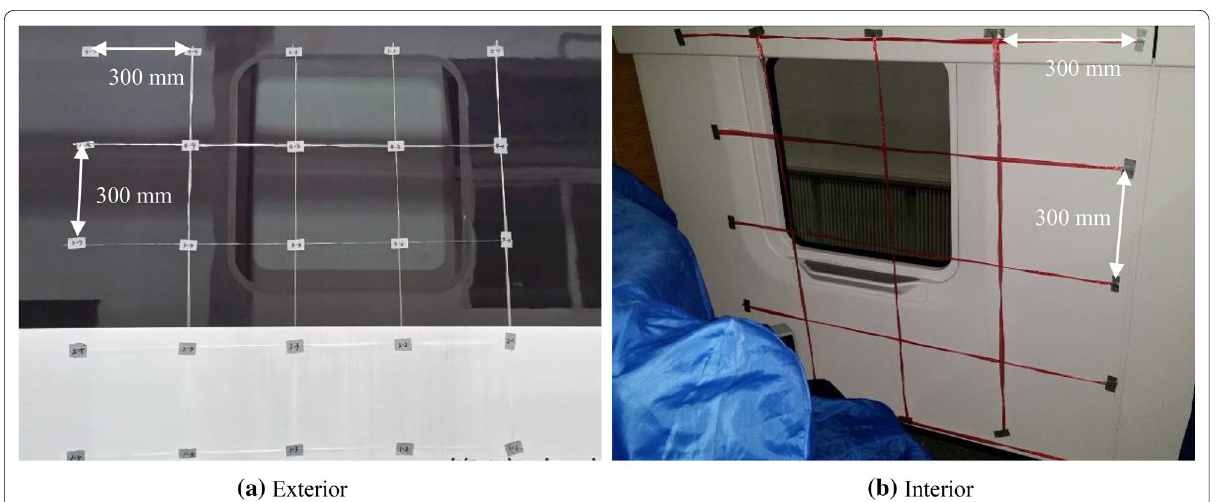
Figure 14 Measurement points on the